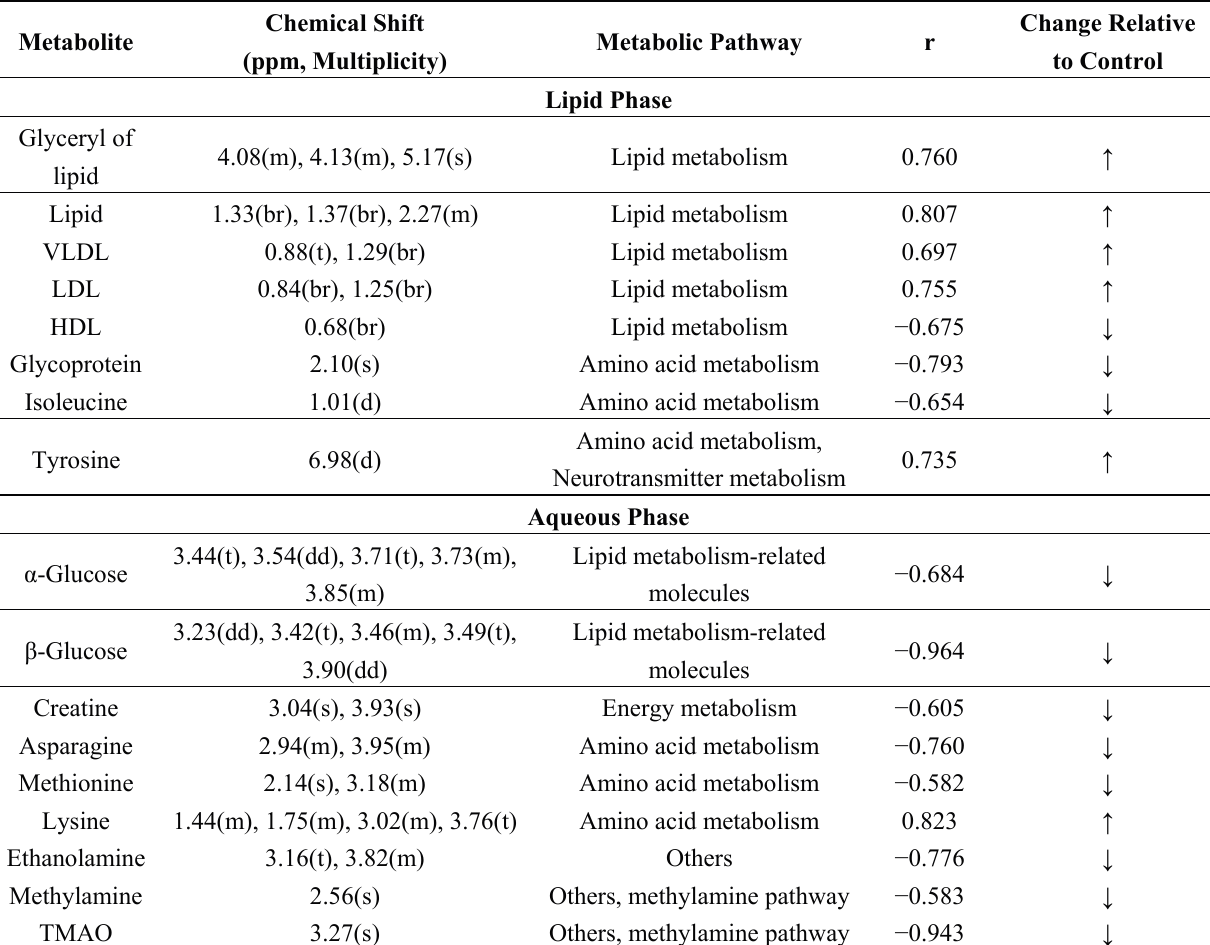
Table 1. Key metabolites discriminating fluoxetine-treated astrocytes and untreated controls in the OPLS-DA